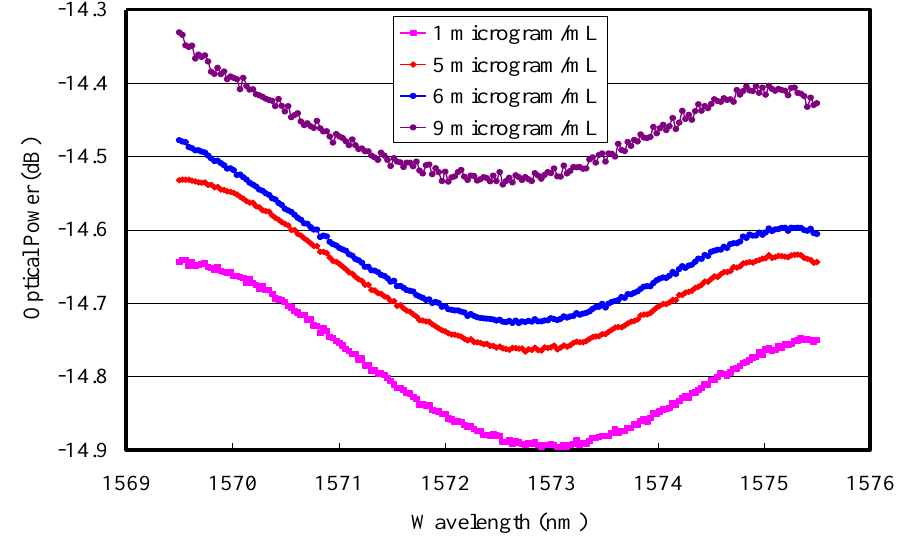
Figure 2. SPR wavelength modulation for different MTB DNA concentrations without immobilization.